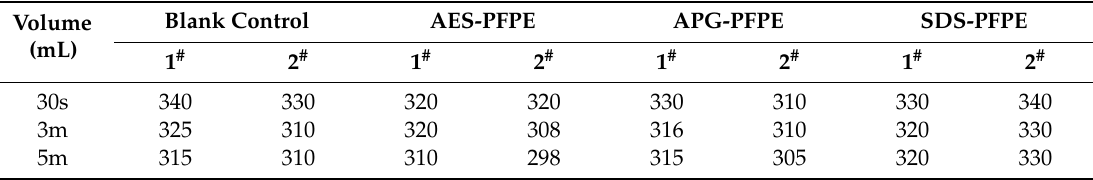
Table 6. Foam property test of emulsions with various